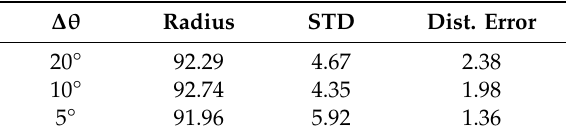
Table 4. Experimental results were obtained at 480 lux (mm).